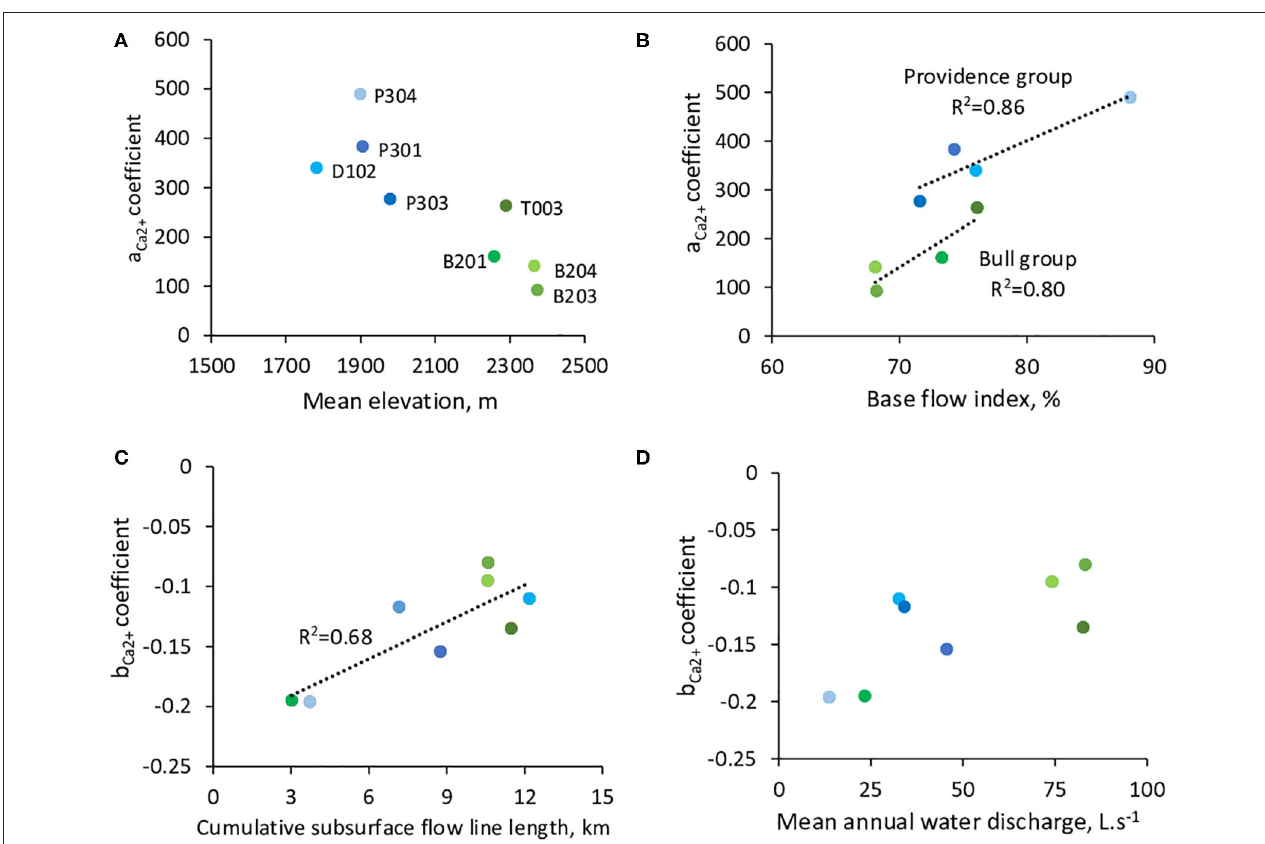
FIGURE 6 | Relations between C-Q shapes (a ca 2 + and b ca 2 + coefficients) and a selection of geomorphologic and hydrologic features for the KREW watersheds. (A) a ca 2 + vs. mean watershed elevations (m). (B) Relationship between a ca 2 + and the base flow index for the KREW watersheds. The values of base flow index are from Safeeq and Hunsaker (2016). (C) b ca 2 + vs. cumulative length of the subsurface flow lines. (D) b ca 2 + vs. mean annual water discharge from the streams at the outlets.